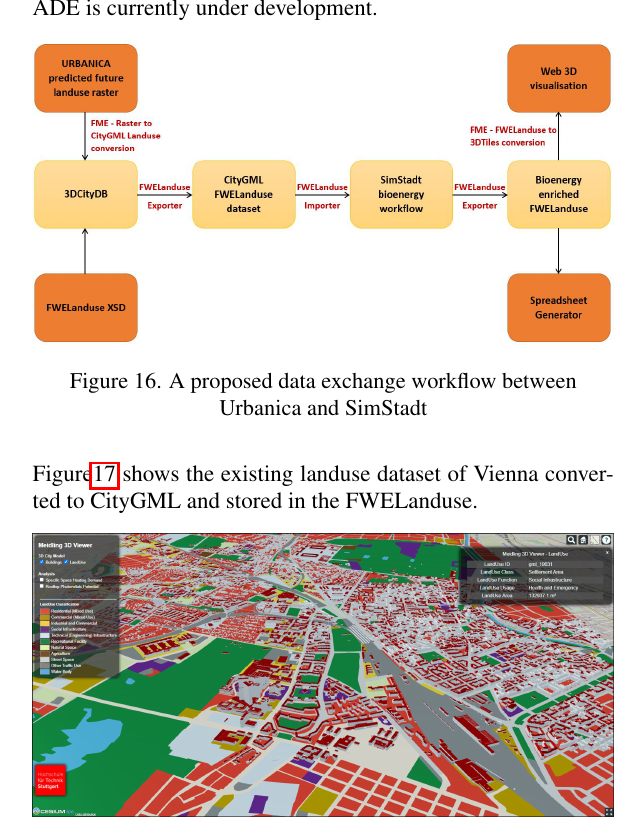
Figure 17. Meidling’s landuse data visualised with its building stock on web